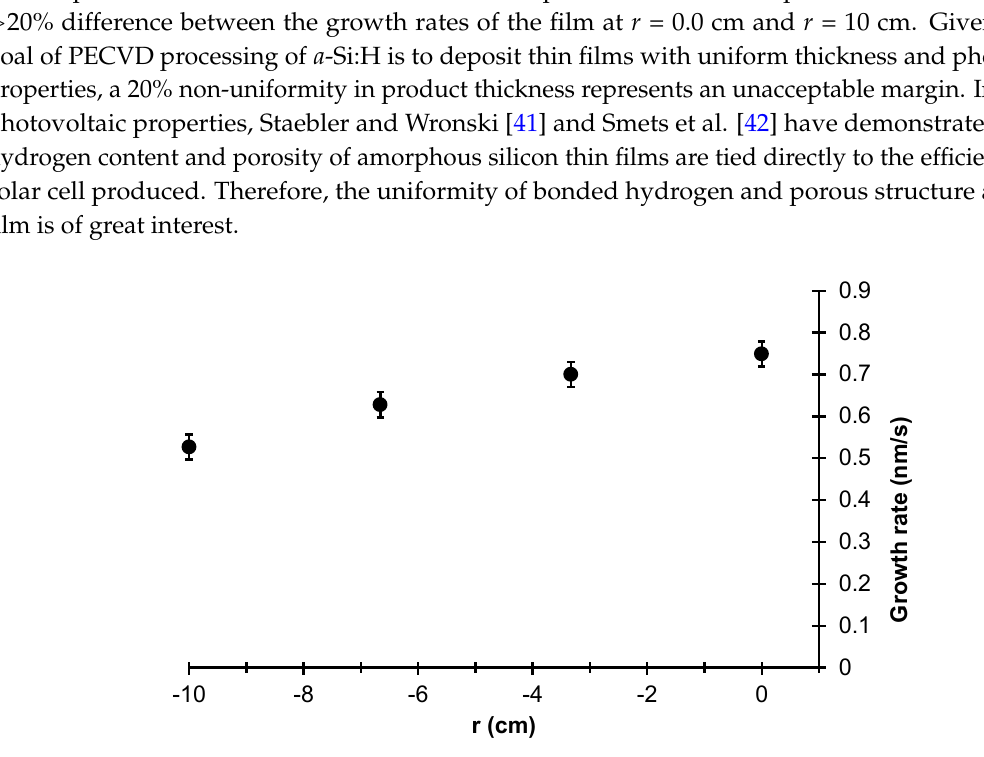
Figure 24. Open-loop drift and spatial non-uniformity in the four radial wafer